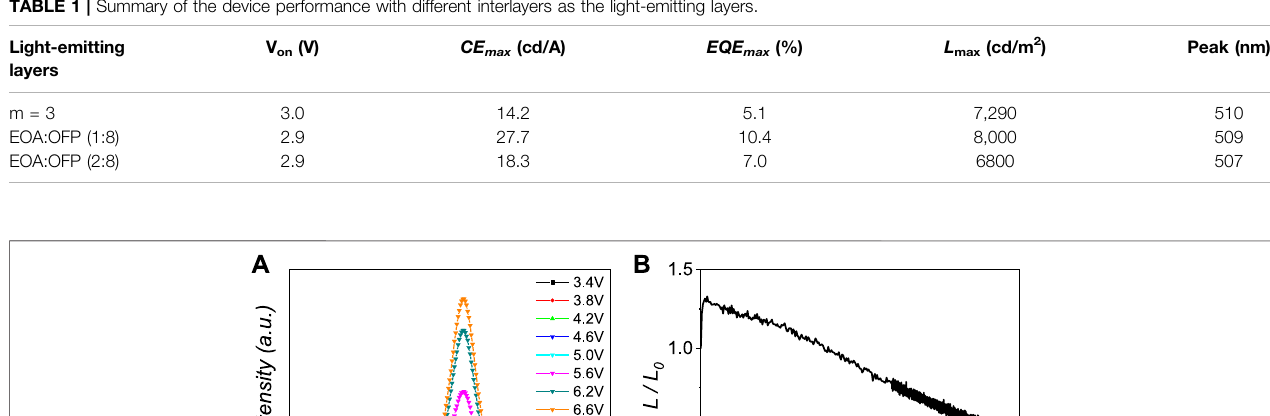
Figure 3B shows the current density (J) – voltage (V) – luminance (L) spectra. Here, the decreased V on of mix- interlayer perovskites comes from the slightly reduced hole carrier injection barrier.